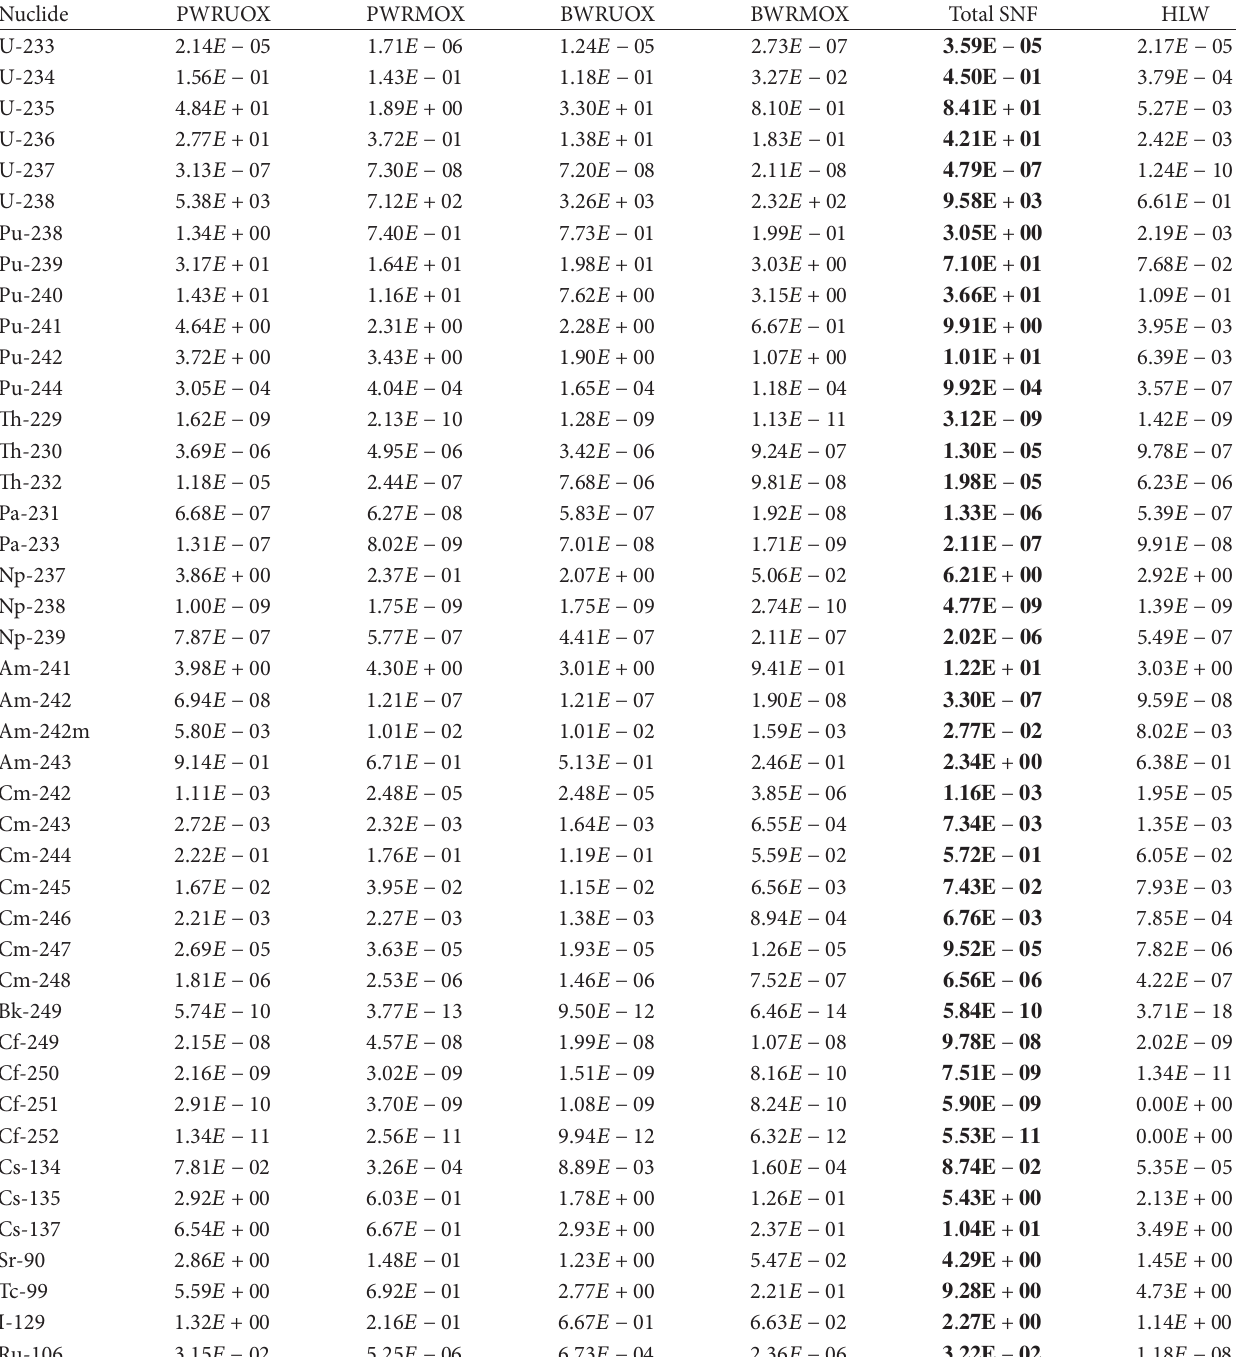
T 2: Selected isotopic inventories (tonnes) in 2022 of German SNF and